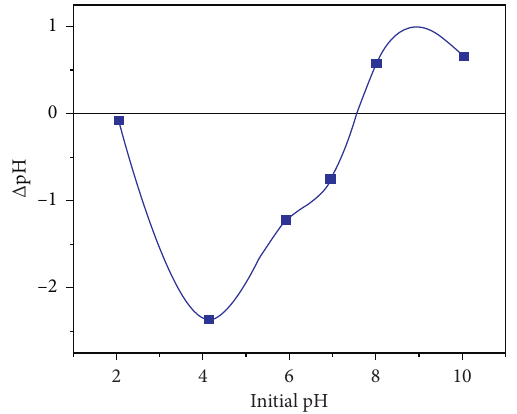
Figure 8: Point of zero charge of